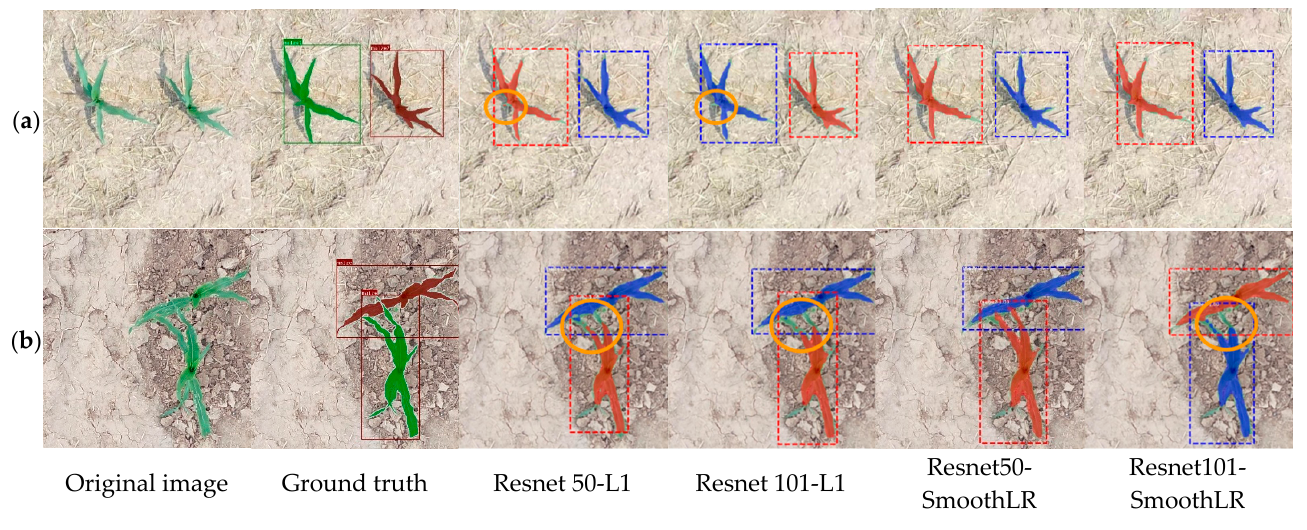
Figure 6. Visualization results of instance segmentation of different Mask R-CNN models on the test set. ( a ) Uncross-covering of adjacent seedling leaves; ( b ) cross-covering of adjacent seedling leaves. The first column shows the original image, and the second column shows the Ground truth of the mask and detection frame, it colors every maize seeding randomly. The third and fourth columns show the detection segmentation results of Resnet50-L1 and ResNet101-L1, respectively. The fifth and sixth columns show the detection segmentation results of Resnet50-SmoothLR and ResNet101-SmoothLR, respectively.